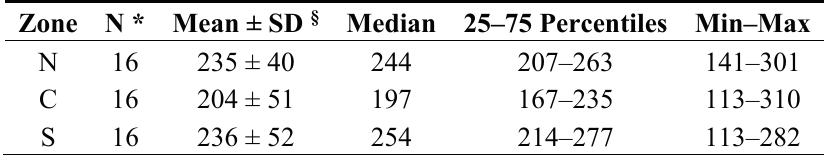
Table 1. Outdoor gamma dose rates (nGy·h –1 ) measured at 1 m from the ground. C, middle.